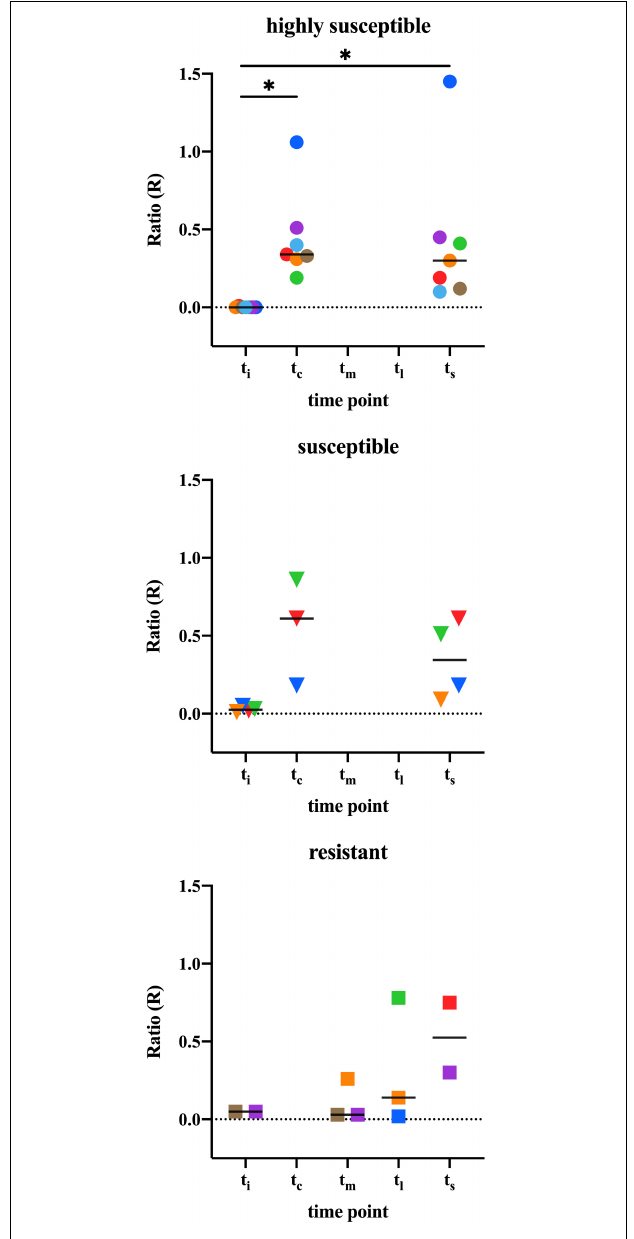
FIGURE 4 | Anti-PGL-I IgM levels by UCP-LFA in M. leprae infected armadillos. Anti-PGL-I IgM levels were measured by UCP-LFA in serum from M. leprae [1 × 10 9 bacilli; NHDP 63 ( n = 9), NHDP 98 ( n = 4), or Brazil 4923 ( n = 4)] infected armadillos divided into highly susceptible ( n = 12; dots; upper panel), susceptible ( n = 4; triangles; middle panel), and resistant ( n = 6; squares, lower panel); sample derived from each animal is represented by the same symbol. UCP-LFA results are displayed as the Ratio value (R) between Test (T) and Flow-Control (FC) signal ( y- axis). The cut-off value for discrimination between infected vs. uninfected animals is R > 0.07. The median values of each group are indicated by horizontal lines. Differences between pre-infection (t i ) vs. post-infection (t c /t m /t l /t s ) were determined by Wilcoxon matched-pairs test. P -values: ∗ p < 0.05. t i , time of inoculation; t c , time of seroconversion (for highly susceptible and susceptible animals); t m , mid-stage disease; t l , late-stage disease; t s , time at sacrifice ( < 12 months for highly susceptible; 12–24 months for susceptible; > 36 months for